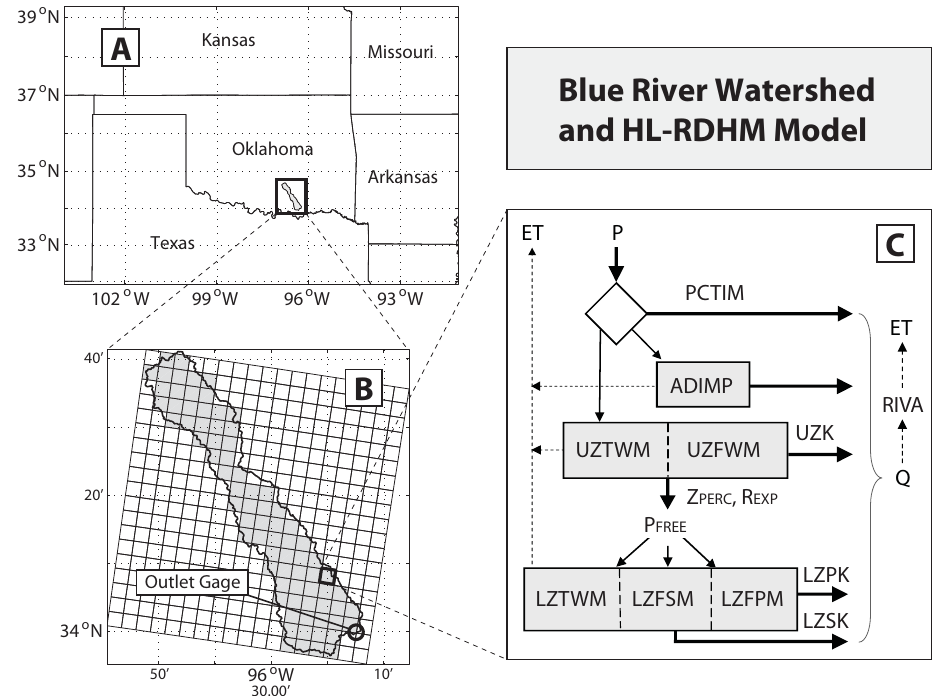
Fig. 1. (A) Location of the Blue River Basin in southern Oklahoma, USA. (B) The 78 HRAP grid cells of the Blue River Basin (shaded). (C) The Sacramento Soil Moisture Accounting (SAC-SMA) model, which simulates the water balance in each grid cell.